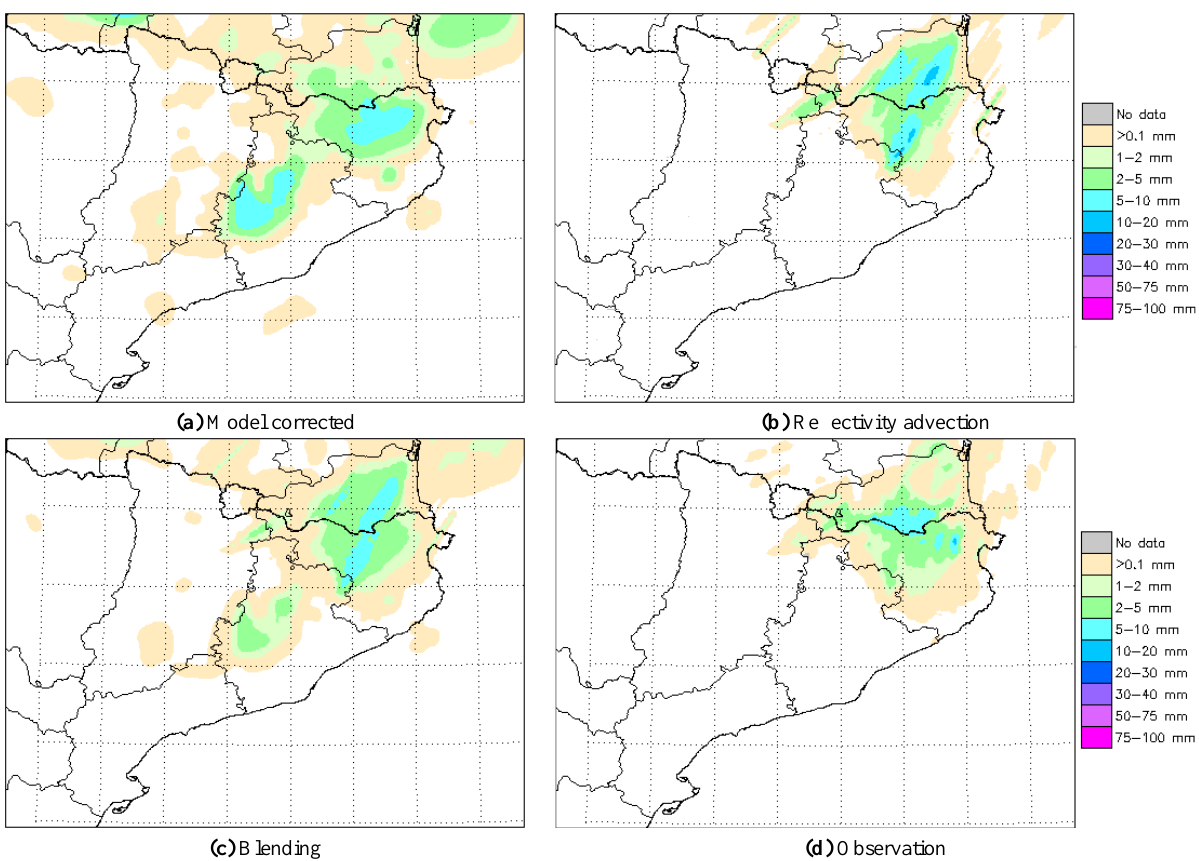
Fig. 5. An example of 22:00UTC blending forecast for the next hour (23:00UTC) of the 14 July 2009 event.